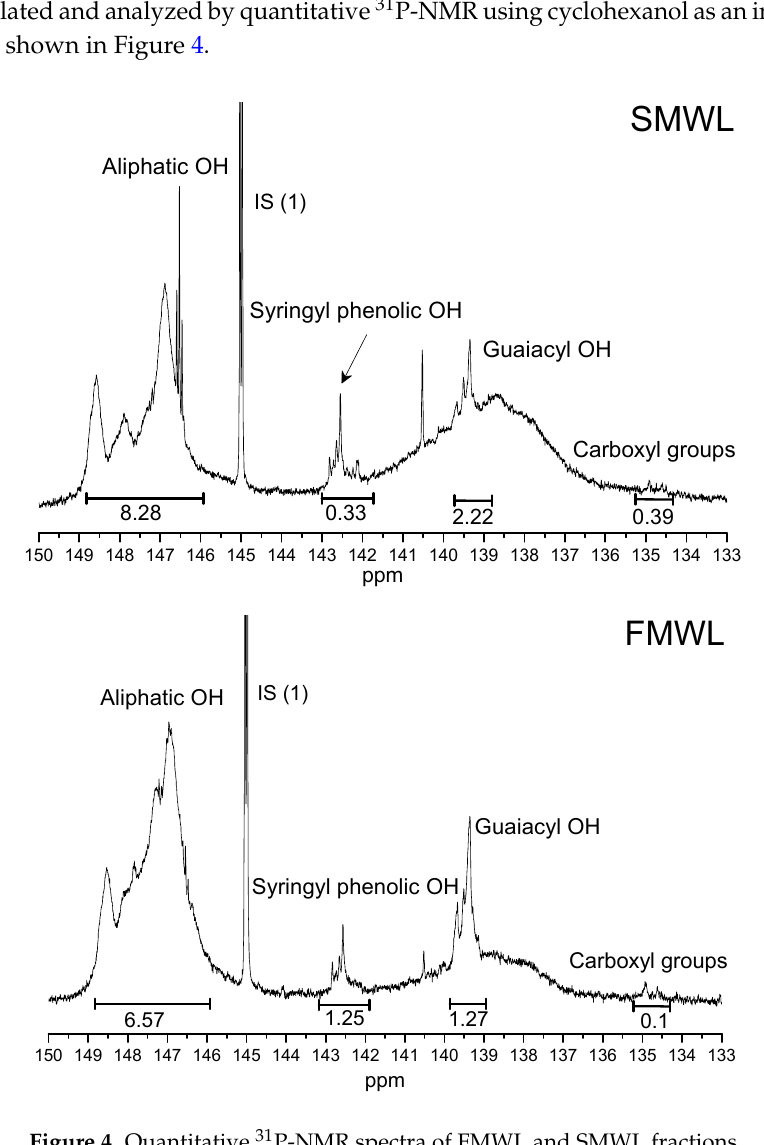
Figure 4. Quantitative 31 P-NMR spectra of FMWL and SMWL fractions.